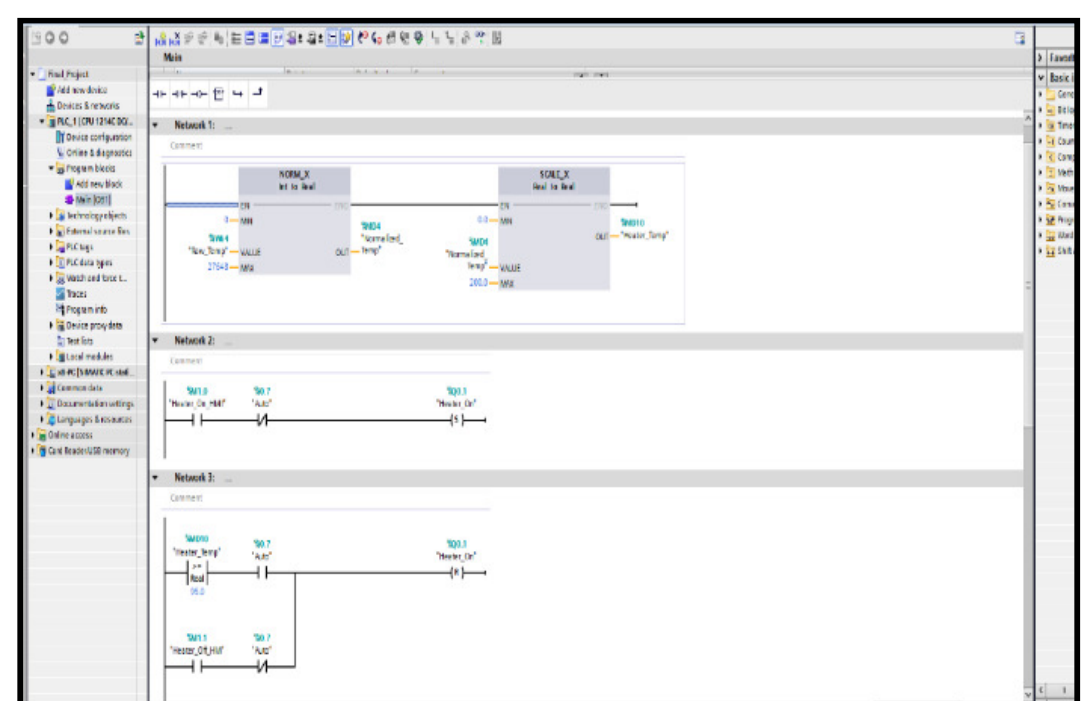
Fig. 4. The PLC tag